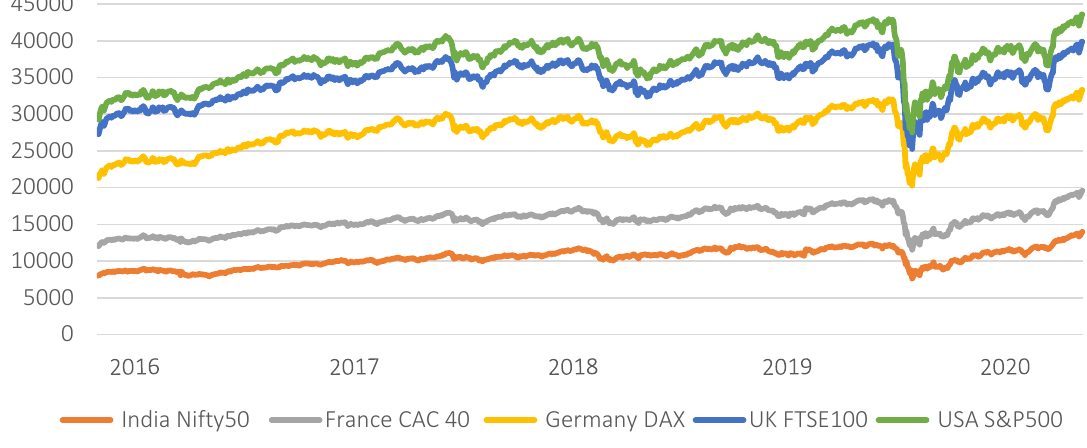
Figure 2. Daily index series for the post-Brexit referendum period